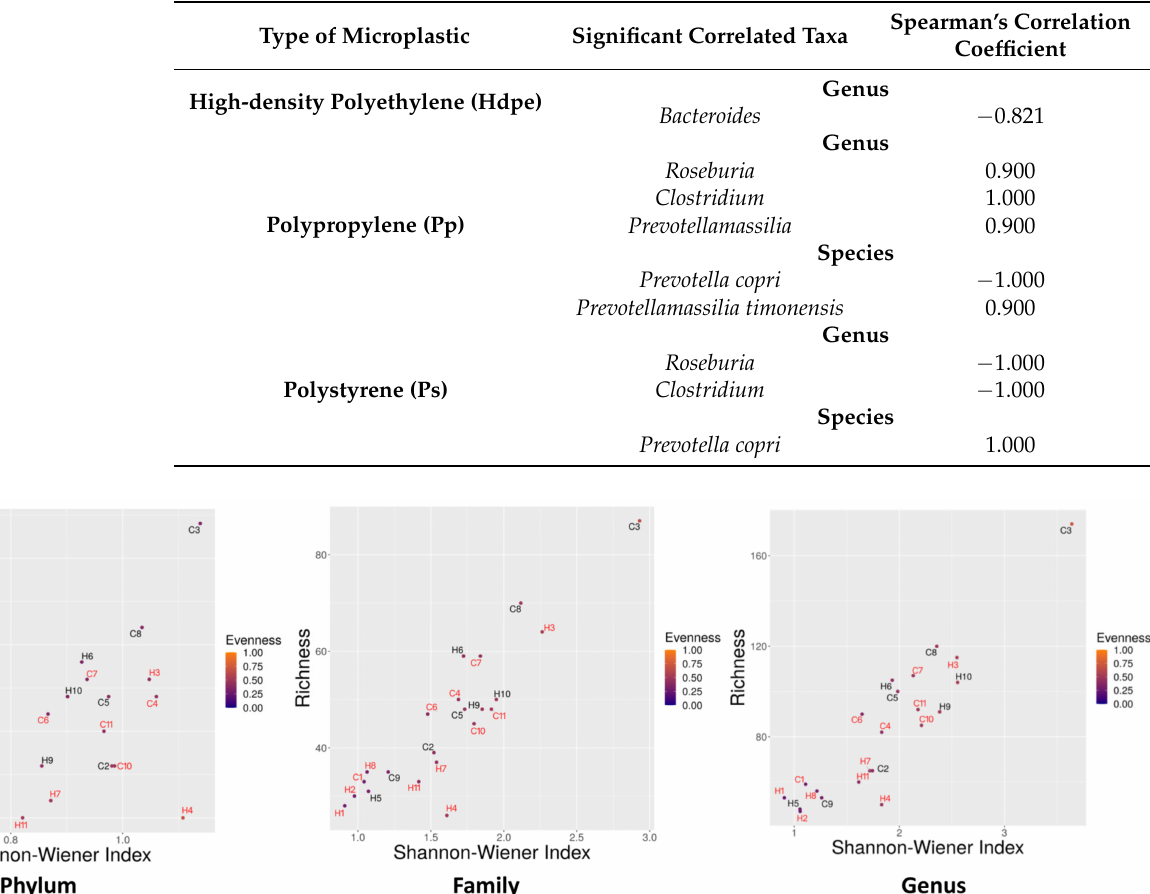
Table 1. Correlation between the level of contamination of microplastic types and the relative abundance of gut bacteria.